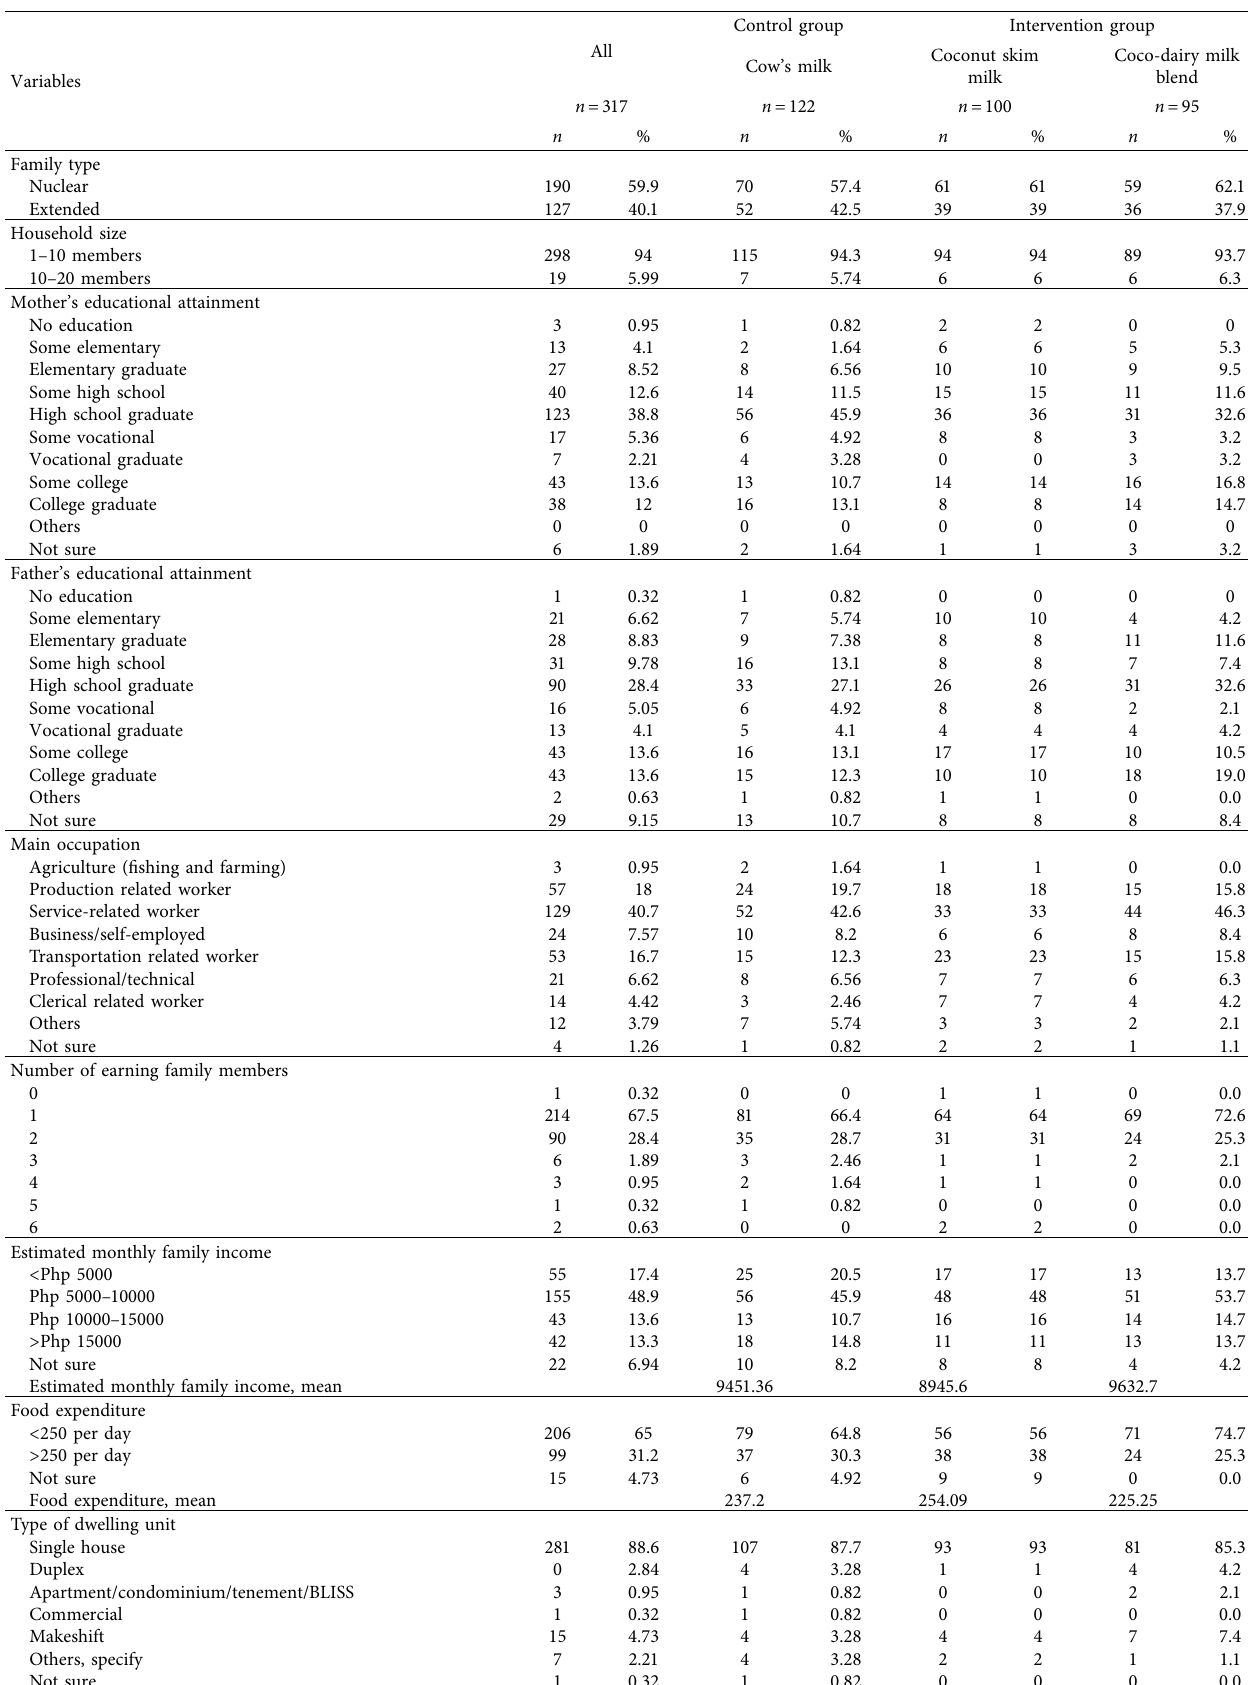
Table 4: Percentage distribution of socio-economic and demographic profile of study